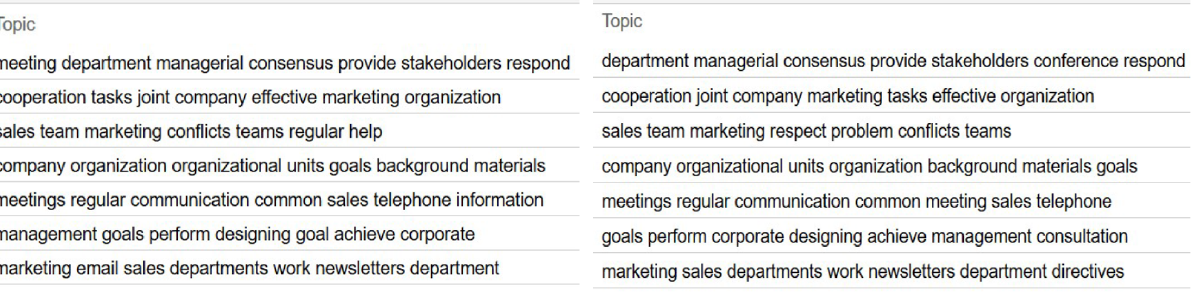
Figure 5. Topics variations from the answers to Question 3 (Own editing using www.voyant.tools.org